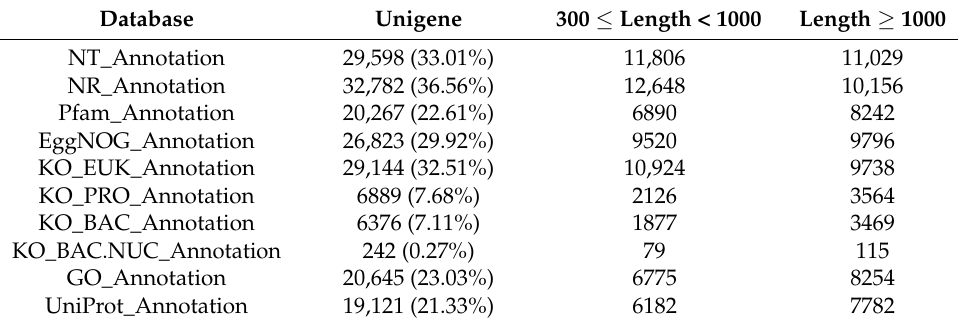
Table 1. Statistics of annotation analysis of